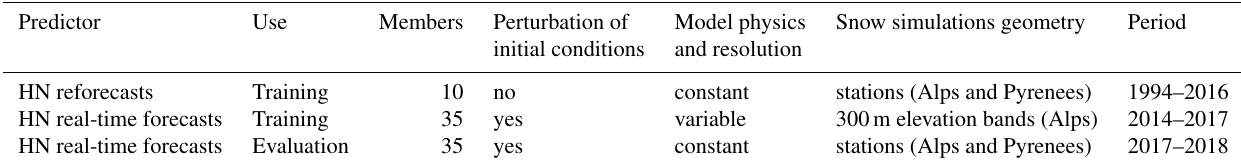
Table 1. Summary of the predictor dataset used for training and evaluation.